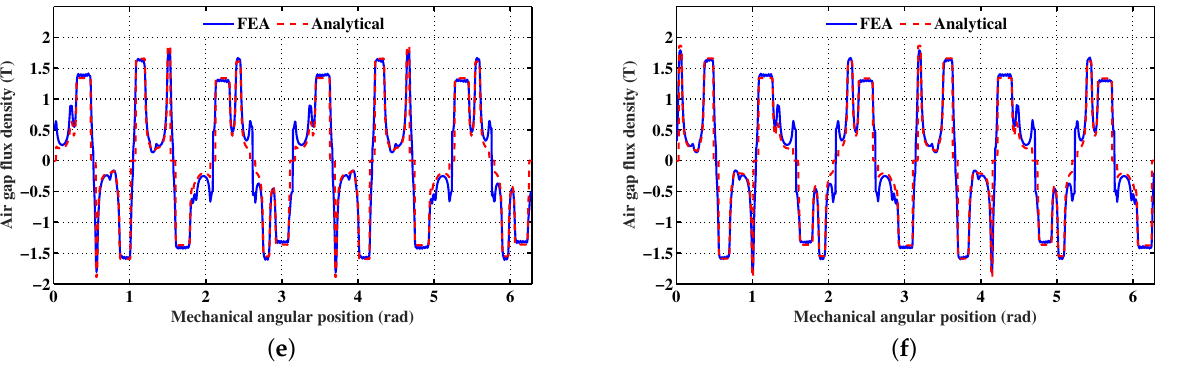
Figure 8. PM flux density spatial repartitions for different rotor positions, with the stator and rotor permeance functions and the rotor position and saturation corrections taken into account. Legend: